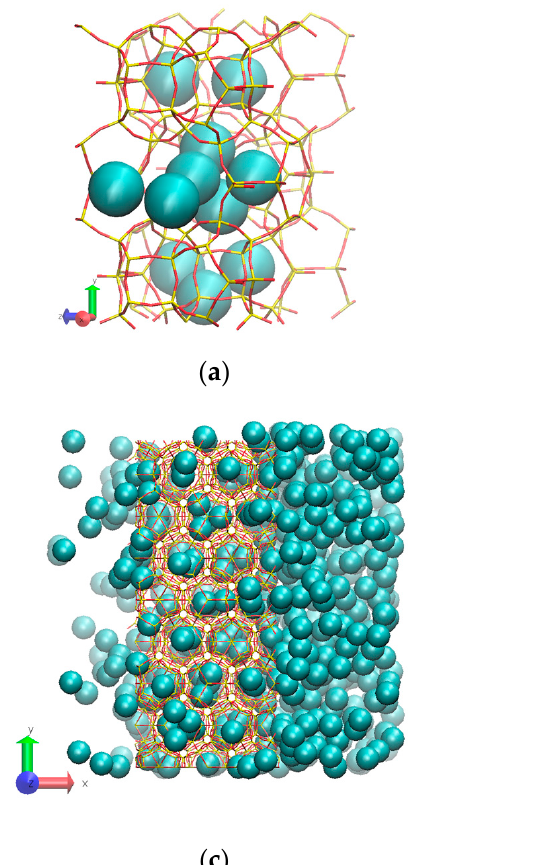
Figure 6. The density profile of krypton at different temperatures, normalized by the total number of atoms of the same species in the system, along the direction normal to the membrane surface, using results from simulation (2) and (3) at 150 atm. The dashed vertical lines correspond to the membrane edges.